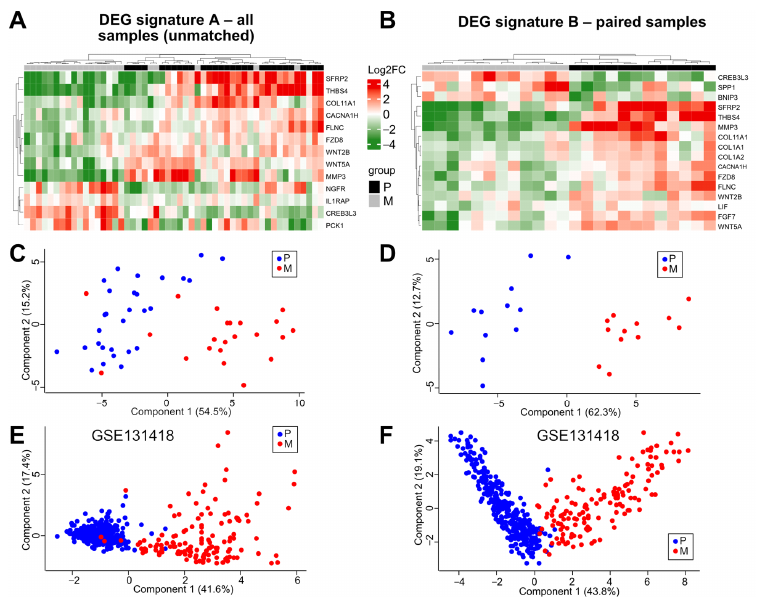
NPV of 0.91 (Figure S4B,D,E). To confirm the capability of the REVEAL signature genes in classifying primary tumors and metastatic colorectal tissue, we performed PCAs with two independent datasets (GSE131418: P, n = 333; M (liver), n = 137 and GSE81582: P, n = 23; M, n = 19) with the DEG-A and B genes (Figures 4E,F and S4F,G). Application of both signatures resulted in a clear separation of the primary tumors and metastatic samples. However, a better prediction (GSE131418) was obtained with DEG-A (area under the curve (AUC) = 0.964) compared with DEG-B (AUC = 0.693). These results indicate that the expression pattern of the DEG-A and B genes can classify primary tumors and (post-ther- apeutic) metastatic colorectal tissue.